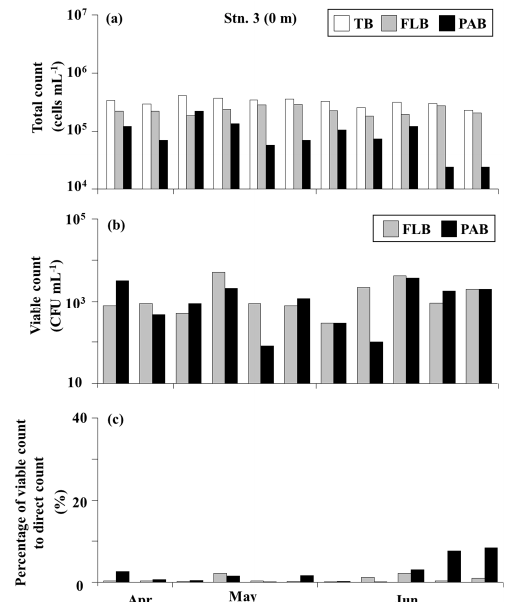
Figure 8. Bacterial numbers in the surface seawater samples from Stn. 3: the direct counts ( a ), the viable counts (CFU) ( b ), and the percentages of viable counts to direct counts ( c ).